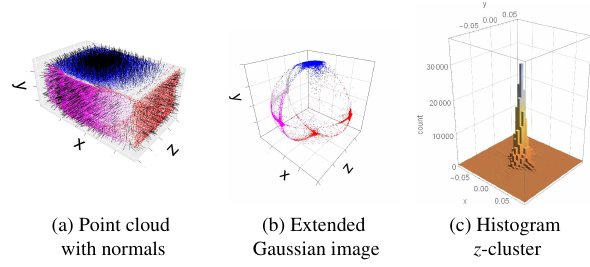
Figure 9. Normals, EGI, and z -axis histogram for Trimble 2. Removing half of the room resulted in five clusters in the EGI.